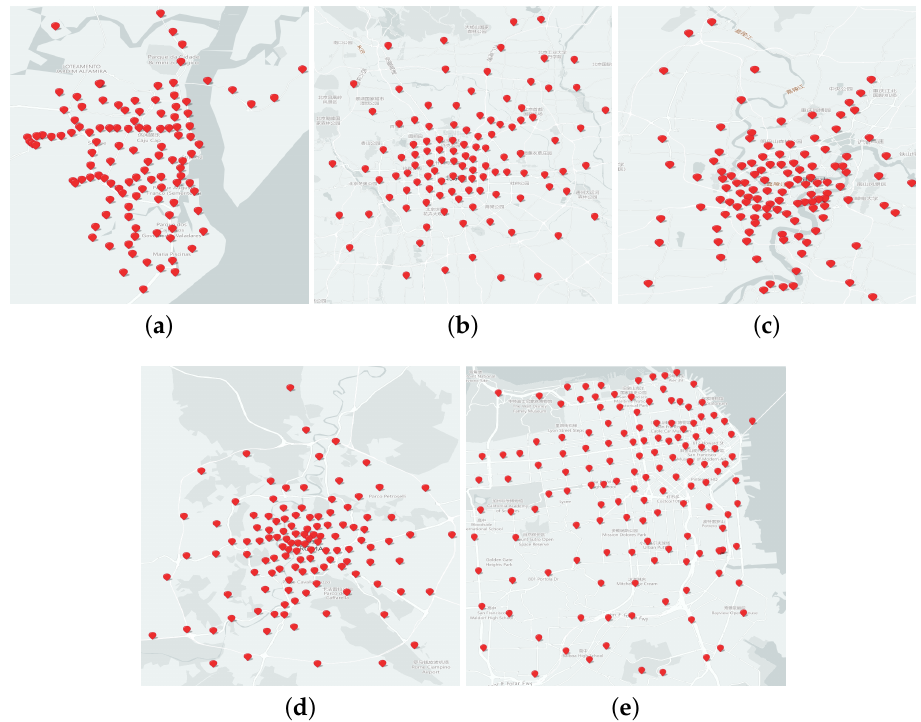
Figure 15. The urban hotspots captured by the PSO-GAK algorithm. ( a ) Aracaju; ( b ) Beijing; ( c ) Chongqing; ( d ) Roma; ( e ) San